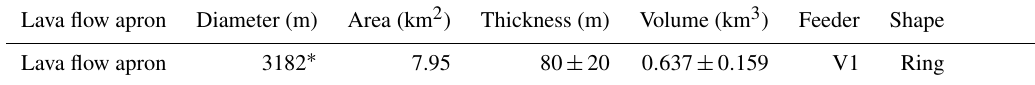
Table 2. Dimensions of lava flow apron. Lava flow apron Diameter (m) Area (km 2 ) Thickness (m) Volume (km 3 ) Feeder Shape Lava flow apron 3182 ∗